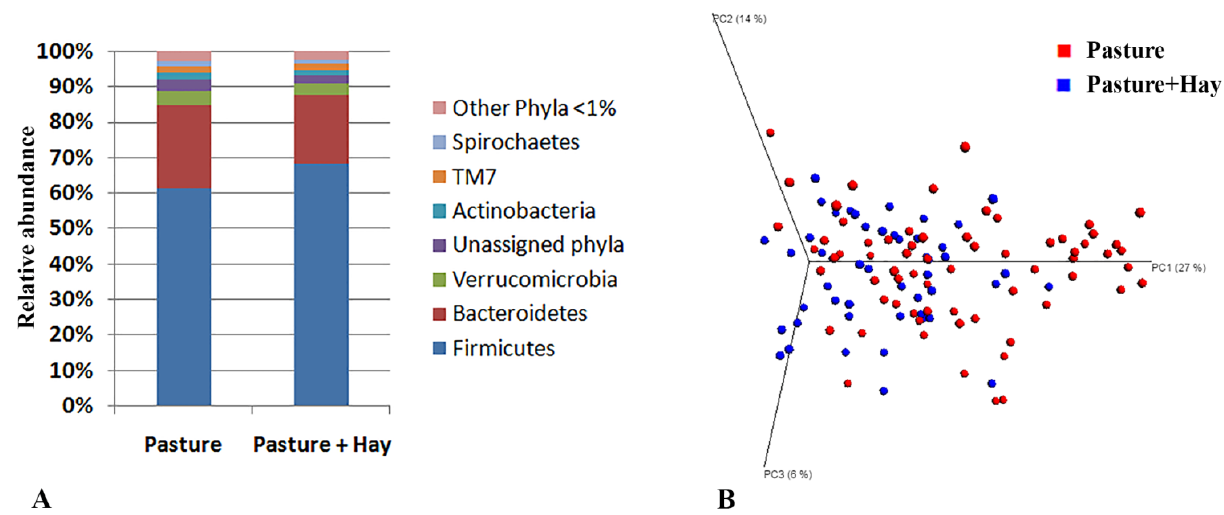
Figure 2. Comparison of the faecal bacterial community across diet periods. ( A ) Mean relative abundance of bacterial phyla identified in the faecal samples of horses fed Pasture versus Pasture + Hay. ( B ) 3-D graph of principal coordinate analysis (PCoA) showing beta diversity of the bacterial community in the faeces of horses fed Pasture and Pasture + Hay. The first three PCs explained 47% of the variation (27% by PC1, 14% by PC2 and 6% by PC3).